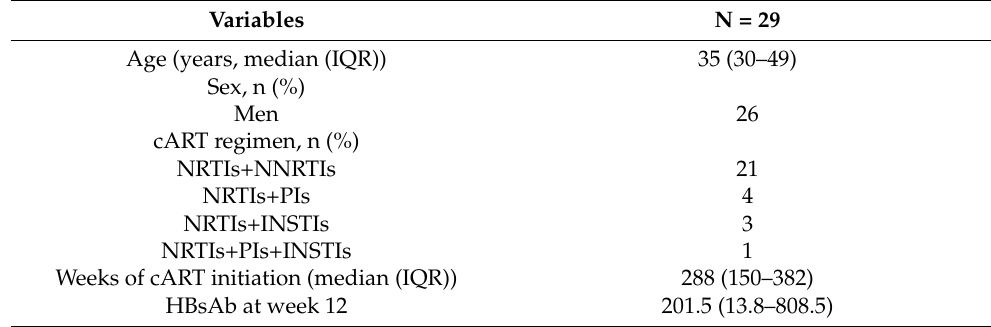
Table 3. Characteristics of participants who sustained protective HBV serological immunity at 102